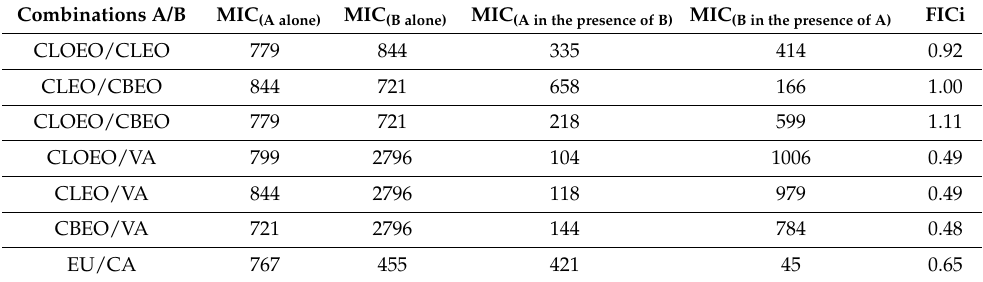
The mixtures CBEO/CLEO and CBEO/CLOEO showed FICi minimal values against L. monocytogenes of 0.66 and 0.70, respectively (Table 2), which qualifies these combina- tions as additive. The isobolograms of both mixtures (Figure 2b,c) were located in the B area. Purkait et al. [56] found even more synergistic effects in the combinations of CBEO and CLOEO with FICi = 0.42 for these EOs, which could be attributed to the different composition of the EOs used.